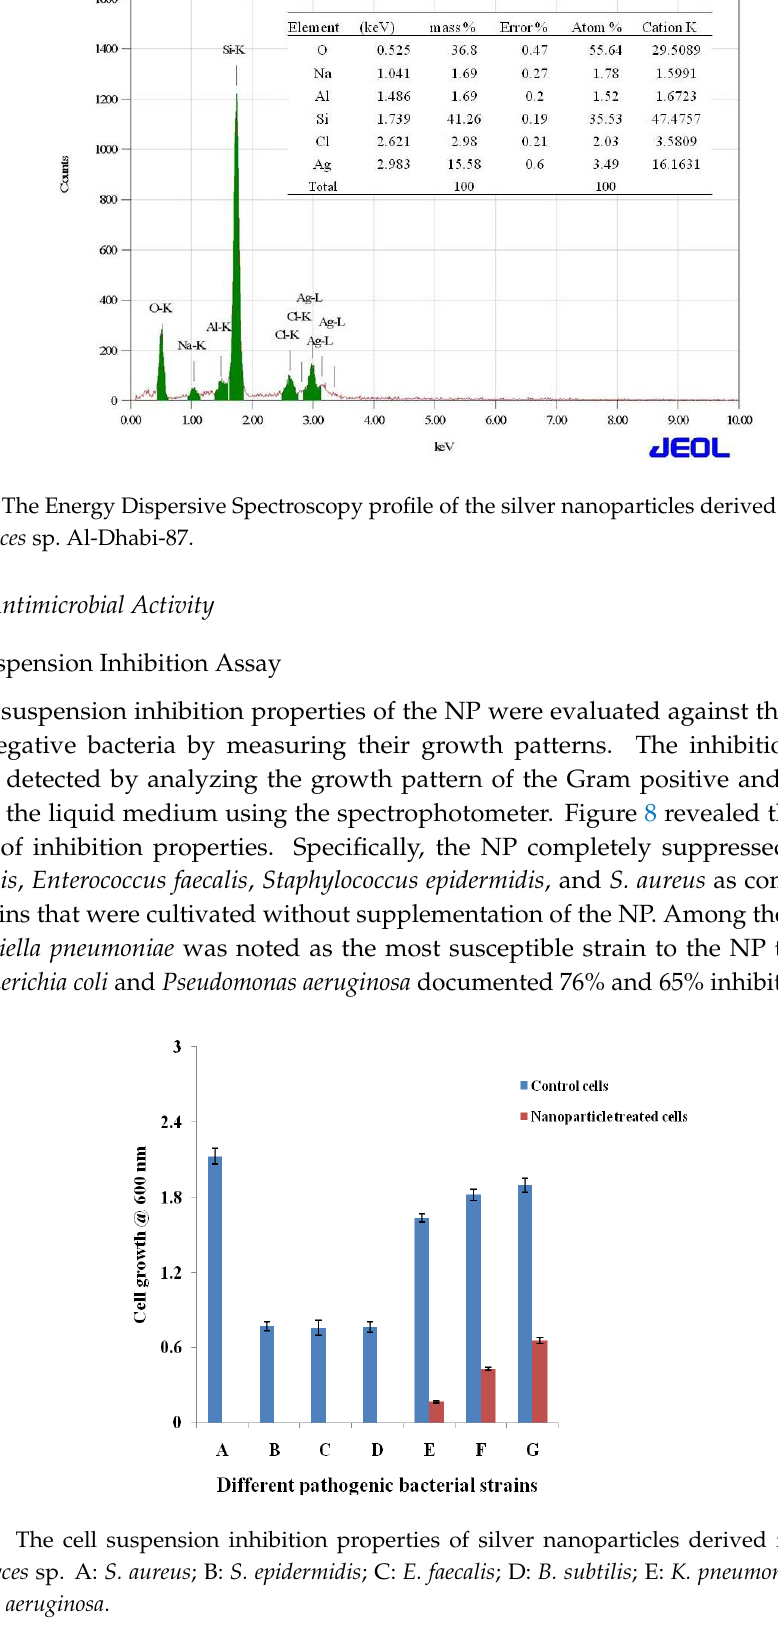
Figure 8. The cell suspension inhibition properties of silver nanoparticles derived from marine Streptomyces sp. A: S. aureus ; B: S. epidermidis ; C: E. faecalis ; D: B. subtilis ; E: K. pneumoniae ; F: E. coli ; and, G: P. aeruginosa